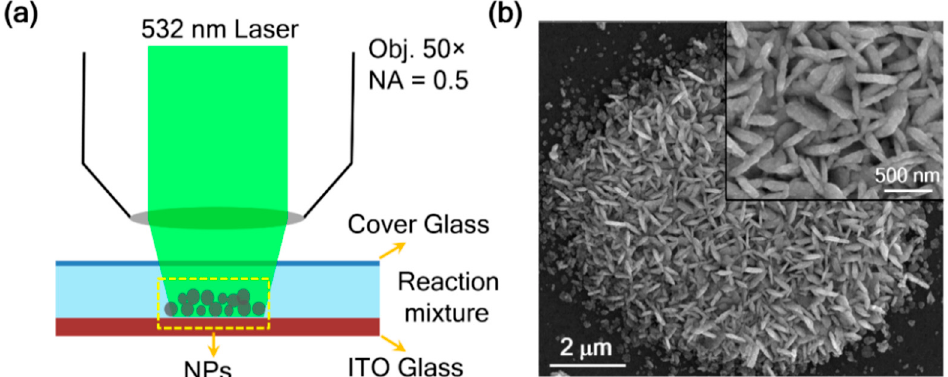
Figure 1. Laser-induced growth of silver aggregates. ( a ) Schematic of the experimental setup. ( b ) SEM image of a typical product fabricated by 60 s exposure at a laser power of 0.9 mW. Inset is a zoomed view of the silver aggregates.